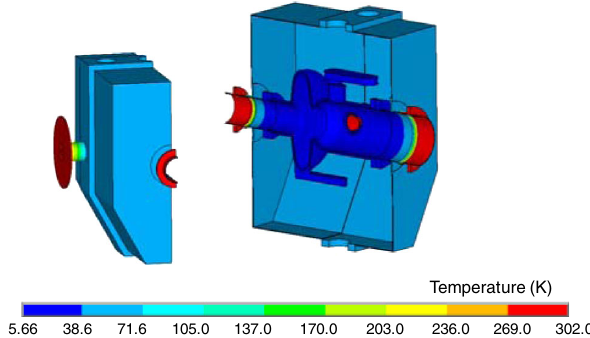
FIG. 14. Temperature distribution for the single cavity operat- ing at a gradient of 5 . 6 MV = m and with 600 kW rf power into each coaxial